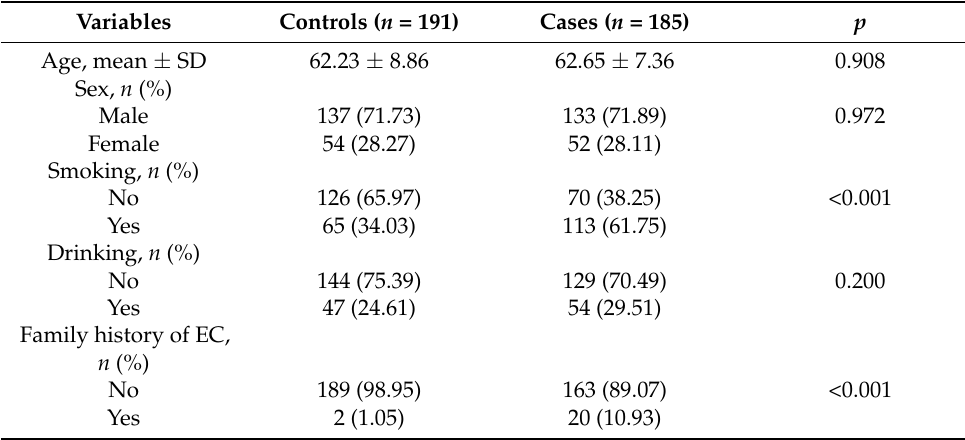
Table 1. Demographic characteristics of the